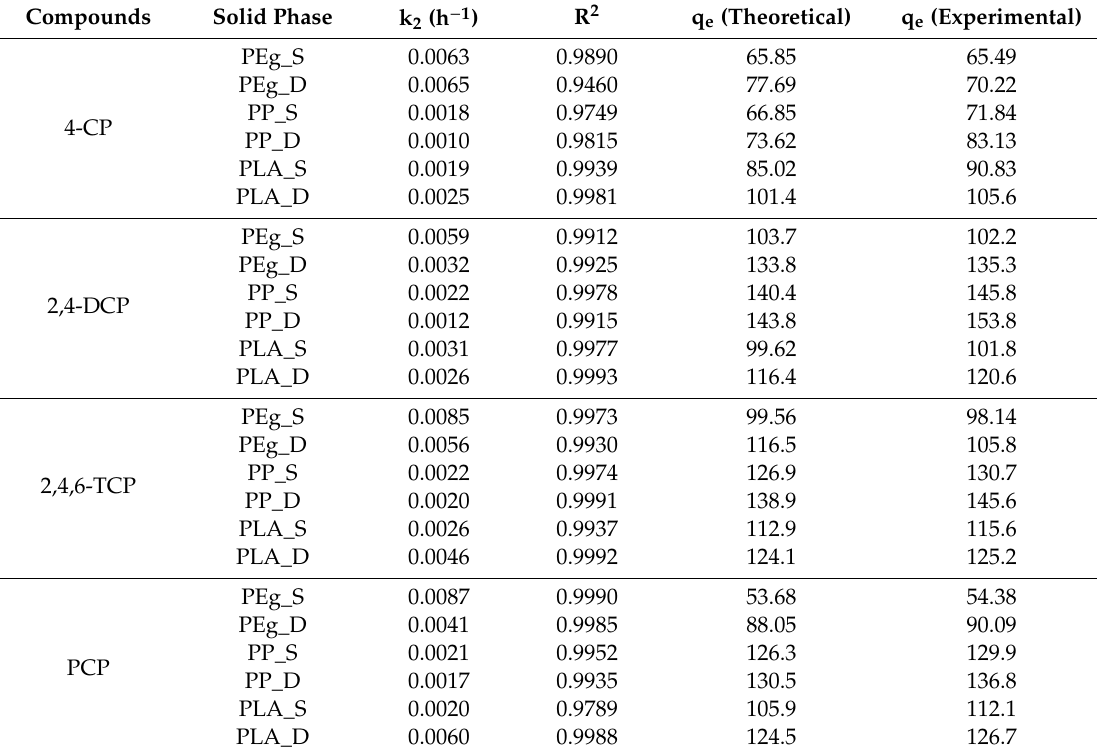
Table 4. Parameters calculated with pseudo-second order kinetic models for the sorption of chlorinated phenols onto PEg, PP and PLA particles in synthetic and Danube river water.